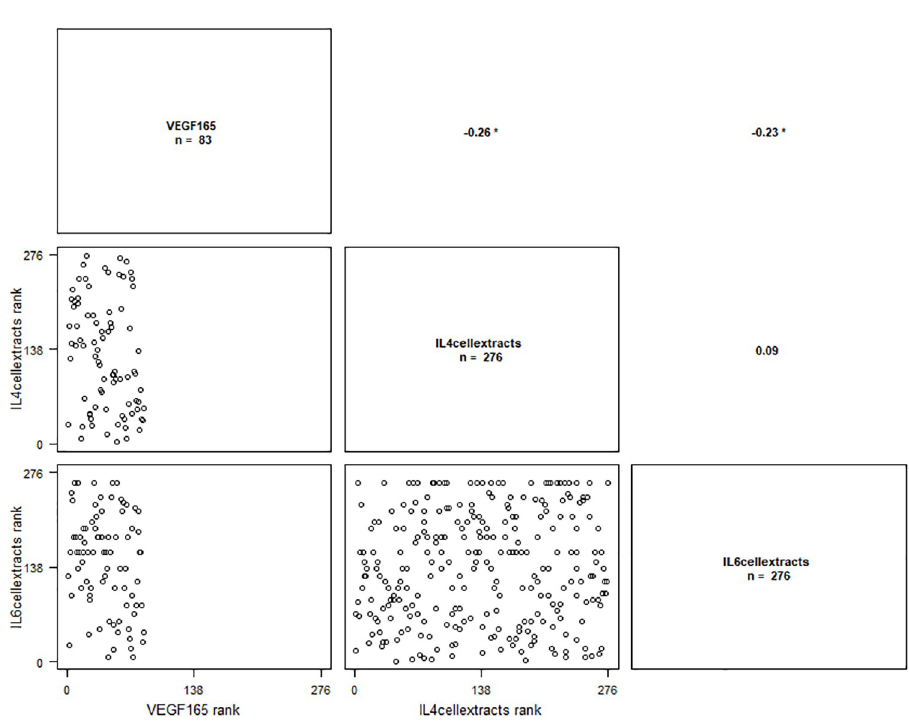
Fig 4. Correlation graph between VEGF p � 0.05.